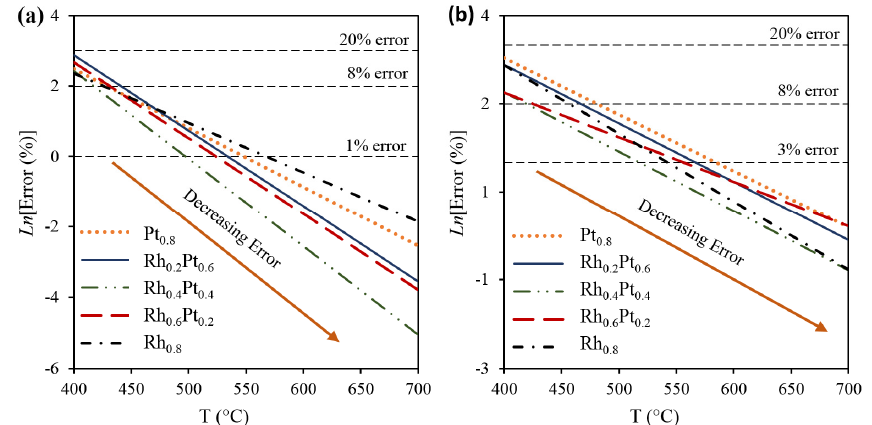
Figure 3. Percentage errors between the experimental data and the results from the RSM-Aspen Plus integration for ( a ) ethanol conversion and ( b ) H 2 yield during SRE over Rh–Pt/CeO 2 . Note that the vertical axis was linearized using Ln to make the difference between the errors more visible.